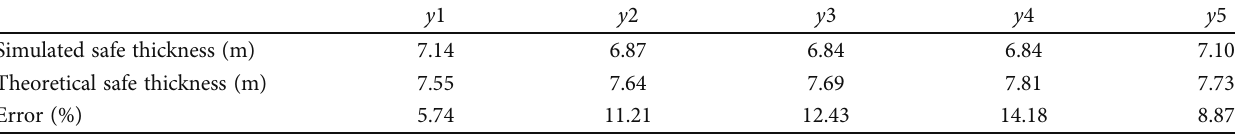
Table 10: Simulated and theoretical values of minimum safe thickness under the condition of shear strength.